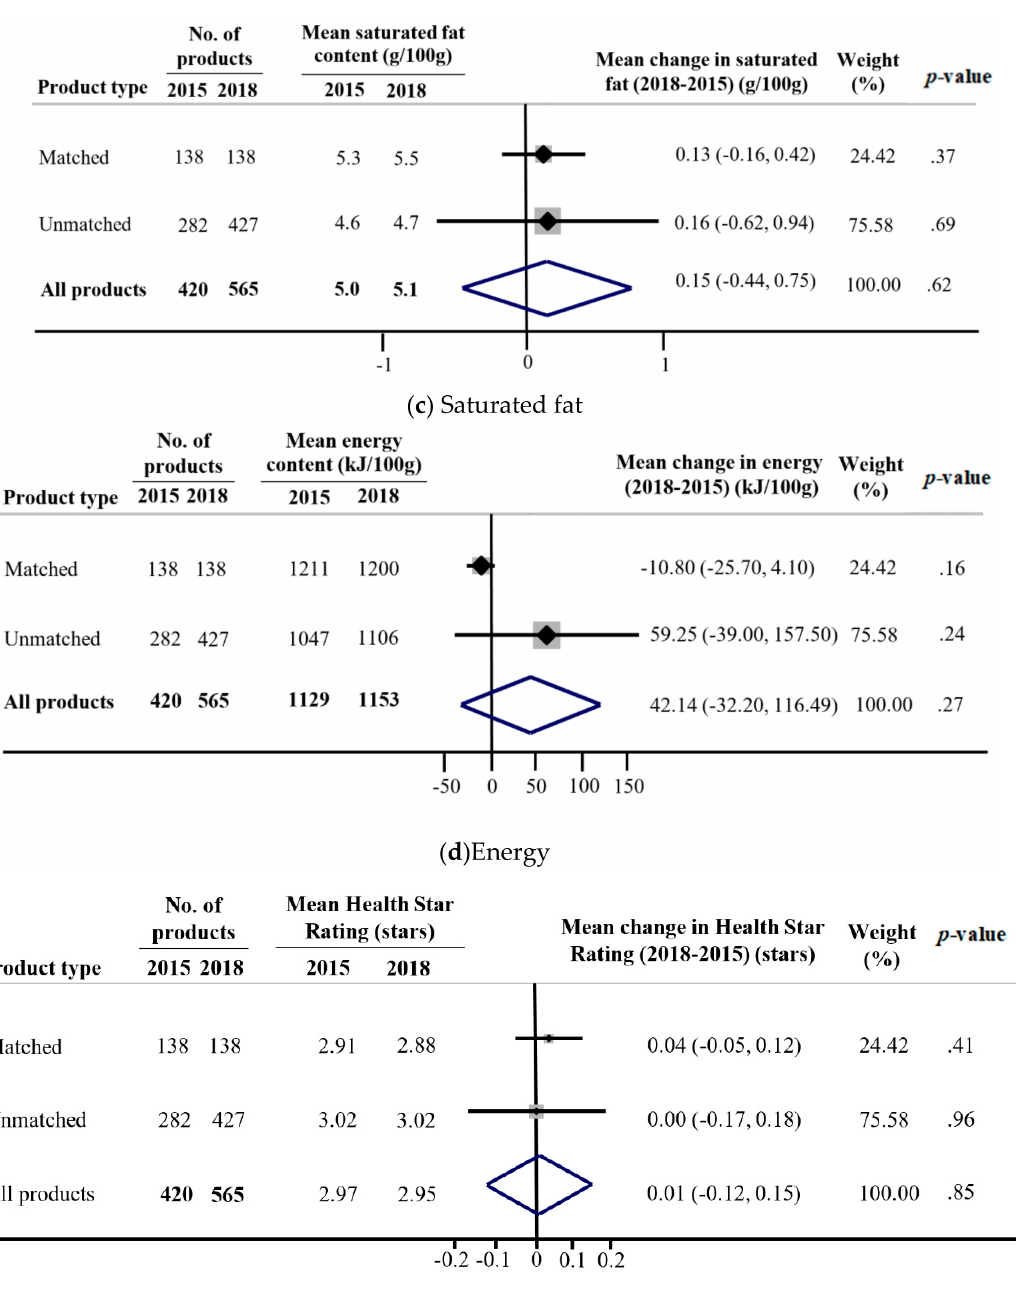
Figure 3. Mean change in nutrient content [sodium (mg/100 g), sugar (g/100 g), saturated fat (g/100 g) and energy (kJ/100 g)] and Health Star Rating between 2015 and 2018 for products in the intervention supermarket. Matched products are products available in both 2015 and 2018 and unmatched products are those available in either 2015 or 2018. Dependent t -tests were used to assess mean differences in nutrient content over time (2015 versus 2018) for the matched products and independent t -tests were used to compare changes over time for unmatched products. Differences in the nutrient content over time were estimated separately for matched and unmatched products and the overall changes were obtained using a summary estimate from a fixed effect meta-analysis. Each meta-analysis was weighted to reflect the proportions of products available in 2018.